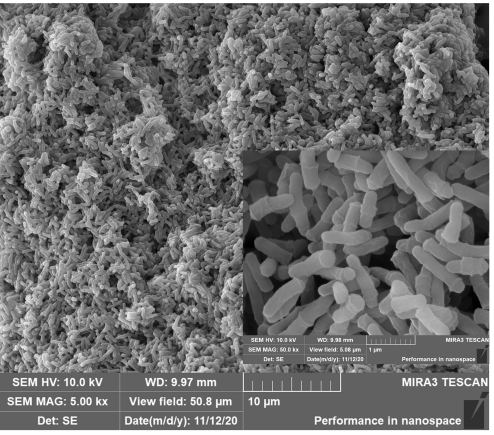
Figure 1. Scanning electron micrograph of strain